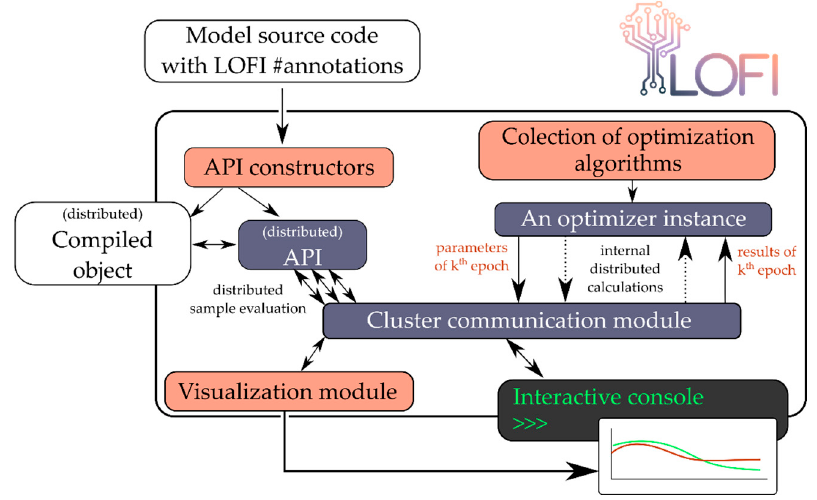
Figure 4. The architecture of the Lofi optimization library.